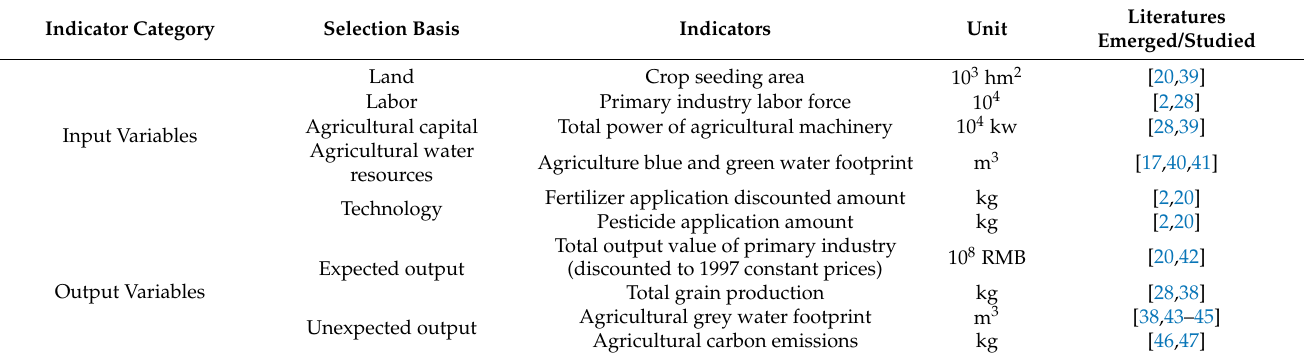
Table 1. The index system of green efficiency of agricultural water